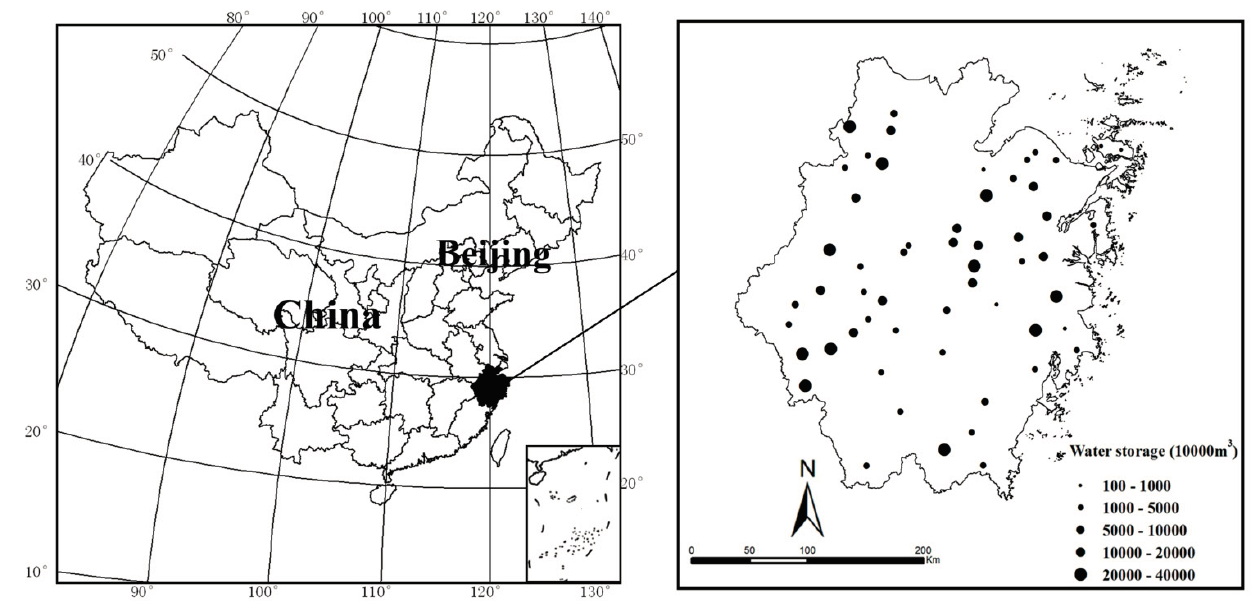
Figure 1. Location of the study area, and the spatial distribution of study